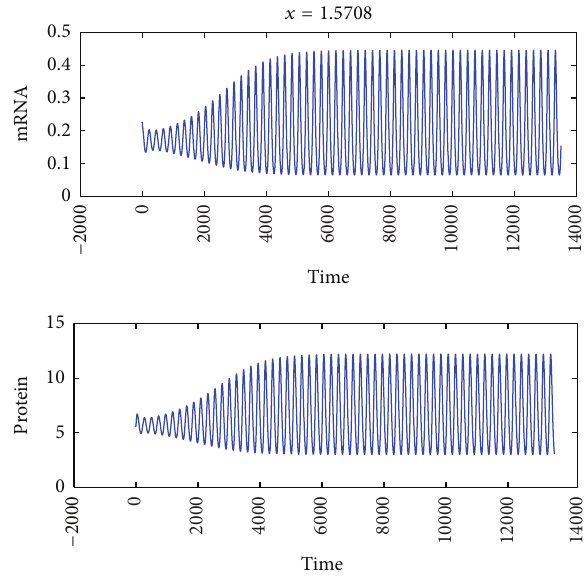
Figure 3: Sustained oscillation when 𝜏 = 30 is much larger than its critical value 𝜏 0 0 ≐ 26.3983 with 𝑑 1 = 0.002 , 𝑑 2 = 0.02 , 𝑏 = 𝑐 = 0.03 , = 0.4 and the initial values are 𝑚 𝑛 = 2,𝑝 0 (𝑥) = 5.6 − 0.01 cos 𝑥 𝑝 0